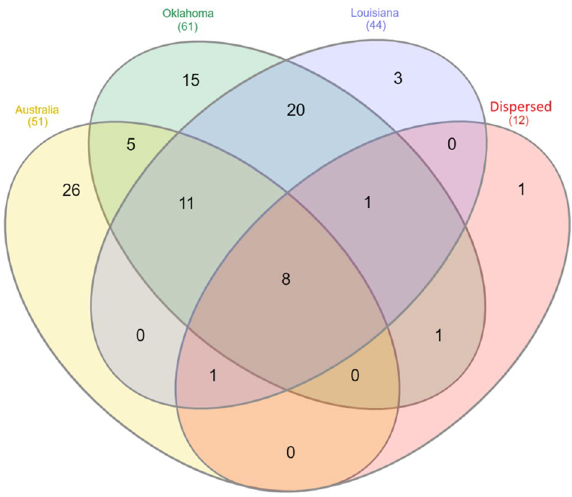
Figure 8. A four set Venn diagram illustrating the most prevalent bacterial genera identified in endometrial lavage samples from Australia, Oklahoma, Louisiana, and Dispersed animals (with a groupwise relative abundance > 0.1%). Eight bacterial genera ( Lactobacillus, Escherichia/Shigella, Streptococcus, Blautia, Staphylococcus, Klebsiella, Acinetobacter, Peptoanaerobacter ) in the intersection of all four sets, was defined as the core